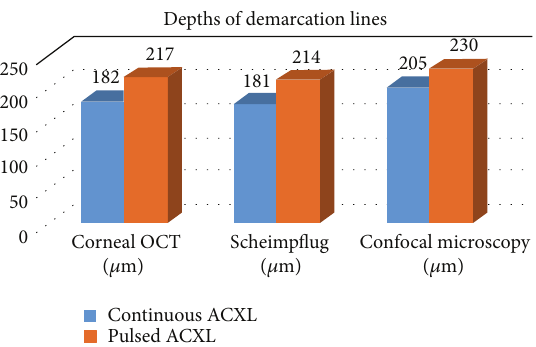
Figure 6: Depths of average demarcation lines recorded one month after continuous light (blue bar) and pulsed light (orange bar) accelerated crosslinking evaluated by corneal OCT (left), Scheimpflug camera (middle), and in vivo confocal microscopy (right) showing a deeper penetration of pulsed light treatment (orange bars) by a mean value of 215 𝜇 m ( ± 20 𝜇 m) versus a lower penetration of continuous light treatment (blue bars) by a mean value of 160 𝜇 m ( ± 20 𝜇 m).